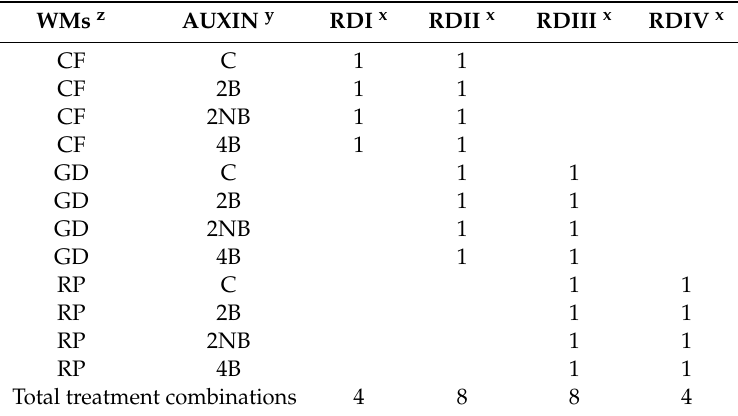
Table 1. Fractional 3-factorial experiment